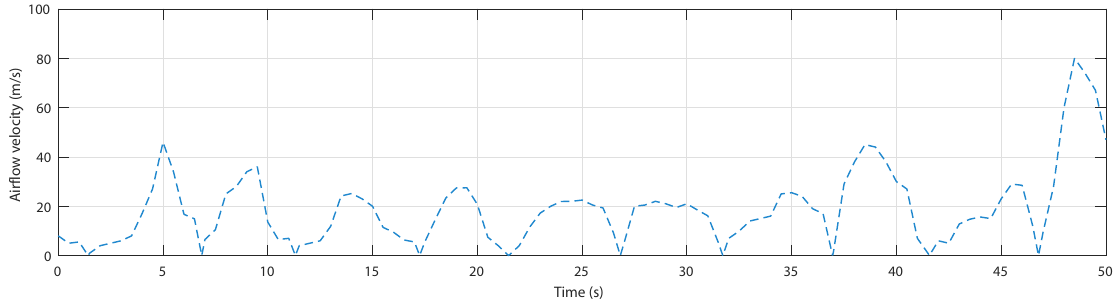
Figure 26. Airflow speed for real measured wave input in the uncontrolled OWC.